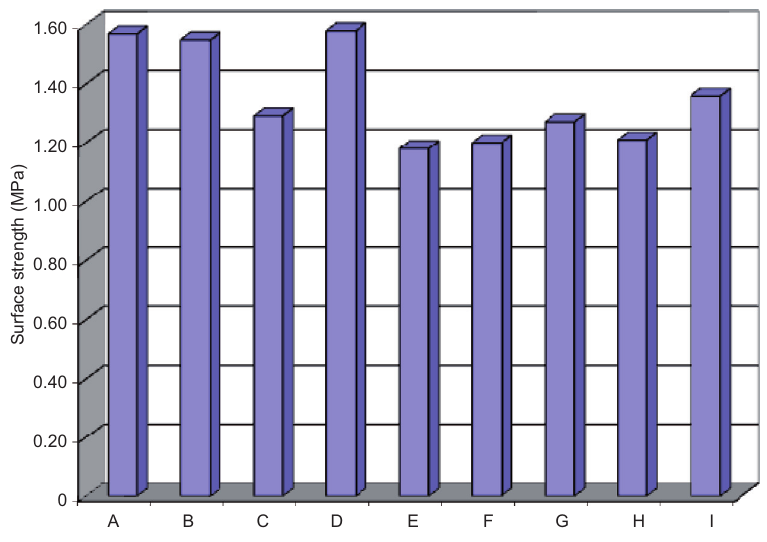
Figure 4 SS of boards. Figure 3 indicates that the apple pruning-based panels have higher IB strength compared with cherry pruning- based panels. The highest IB (1.61 MPa) occurred in board type F, whereas the lowest IB (0.81 MPa) occurred in board type D. A number of researchers have already reported